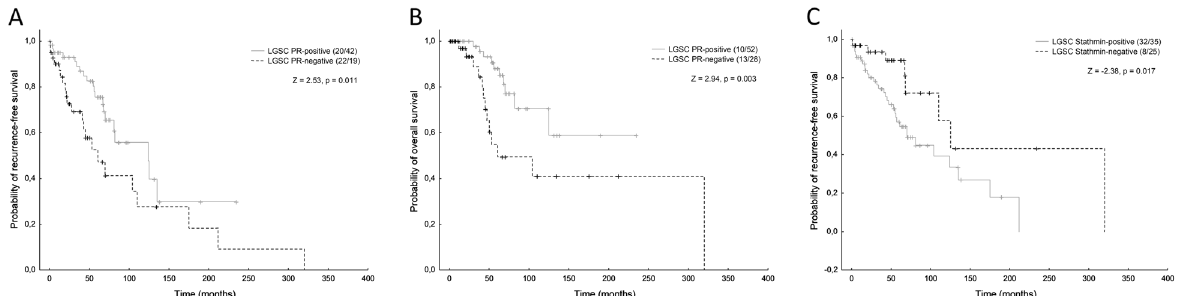
Fig. 3 Survival analyses showing better prognosis for PR positive or stathmin negative LGSCs. Kaplan–Meier curves for A ) recurence-free survival and B ) overall survival in relation to the expression of PR and C ) recurence-free survival in relation to the expression of stathmin in a subset of LGSC/ mSBT. The p -values are based on log rank test, the number of complete/censored cases is stated in the